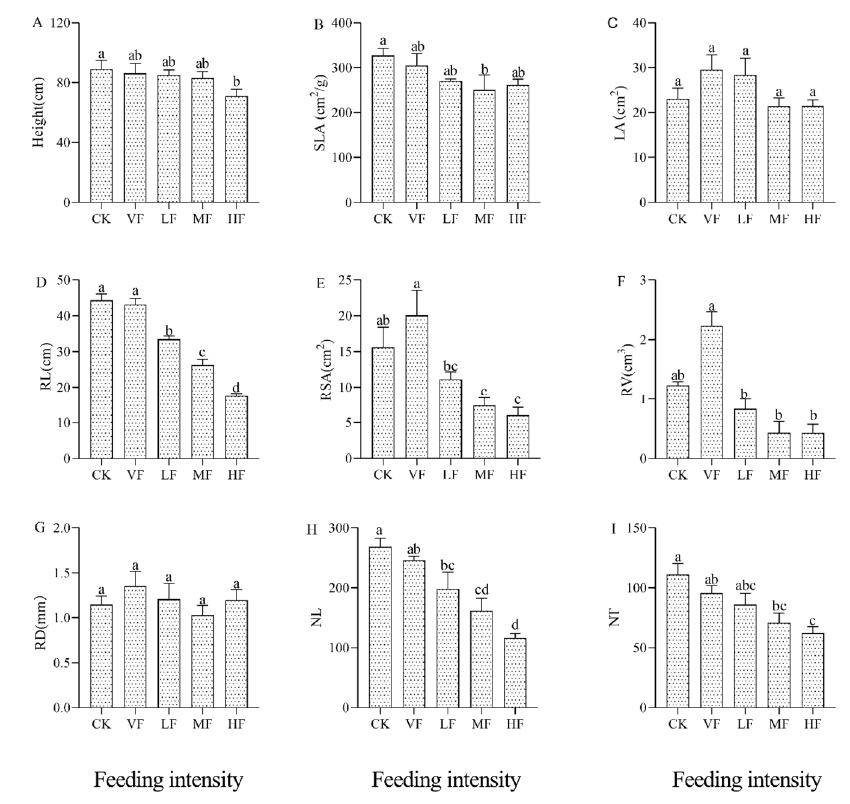
Figure 4. Morphological trait of C. thunbergii in different foraging intensity (CK, no foraging; VF, very little foraging; LF, light foraging; MF, moderate foraging; HF, heavy foraging) showing ( A ) plant height; ( B ) specific leaf area, SLA; ( C ) leaf area, LA; ( D ) root length, RL; ( E ) root surface area, RSA; ( F ) root volume, RV; ( G ) root diameter, RD; ( H ) numbers of links, RL; ( I ) numbers of tips, NT. In each graph, means with the same lowercase letters are not significantly different among foraging intensity ( p > 0.05); means with different lowercase letters are significantly different among foraging intensity ( p < 0.05). Capped lines represent ± standard error.